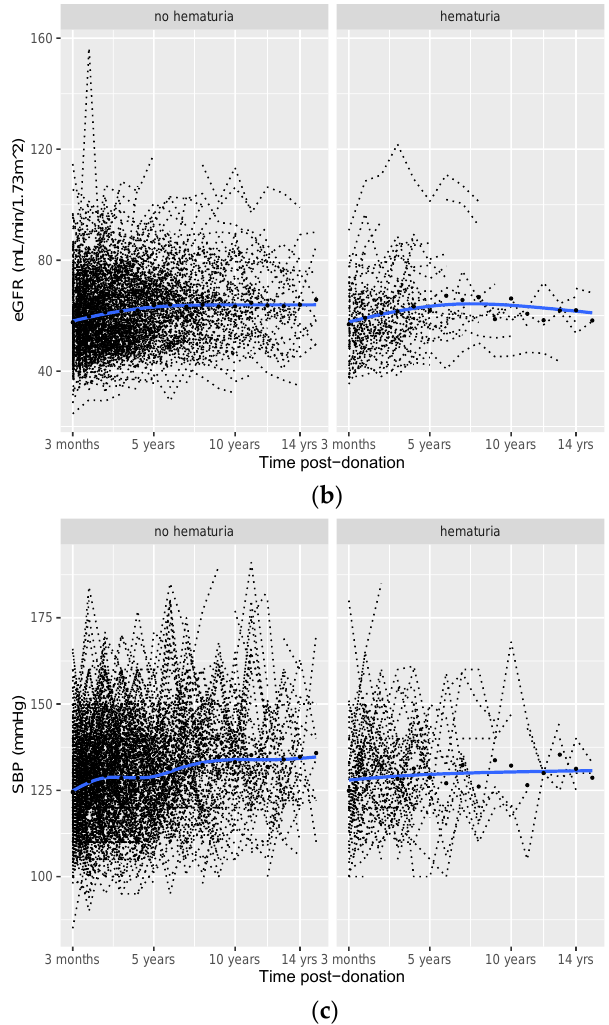
Figure 2. Post-donation course of protein/creatinine ratio (PCR ( a )), eGFR ( b ), and SBP ( c ) in donors with vs. without pre-donation hematuria. Smooth curves (blue lines) with 95% confidence intervals (grey areas), individual trajectories (dashed black lines), and mean (median for PCR) values for each time point (black dots).